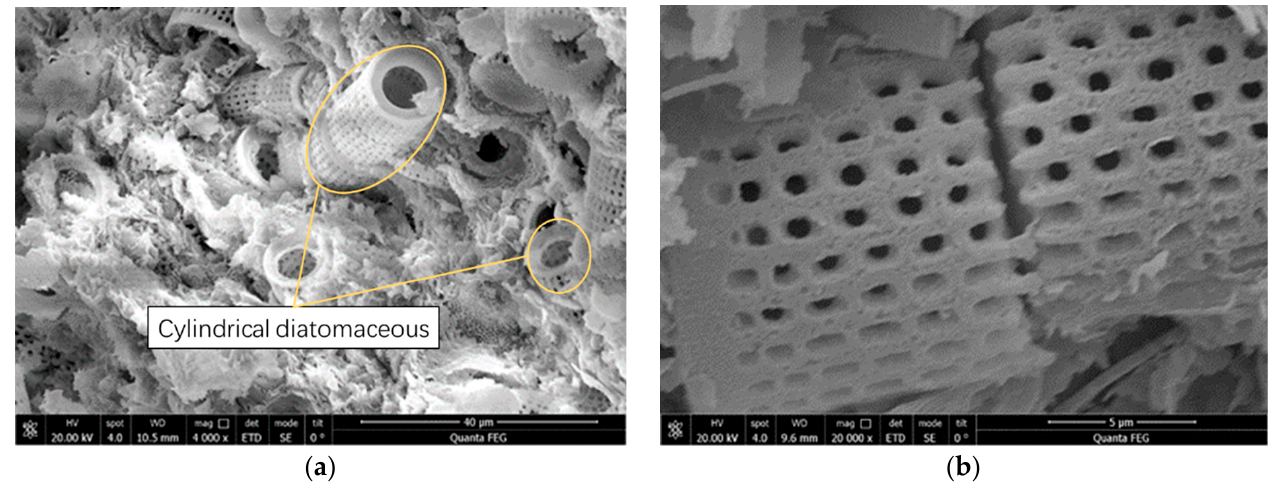
Figure 3. Microstructures of diatomaceous earth determined by scanning electron microscopy: ( a ) white diatomite (4000×); and ( b ) multilevel pores of diatomite. Table 1. Physical properties of diatomaceous earth.